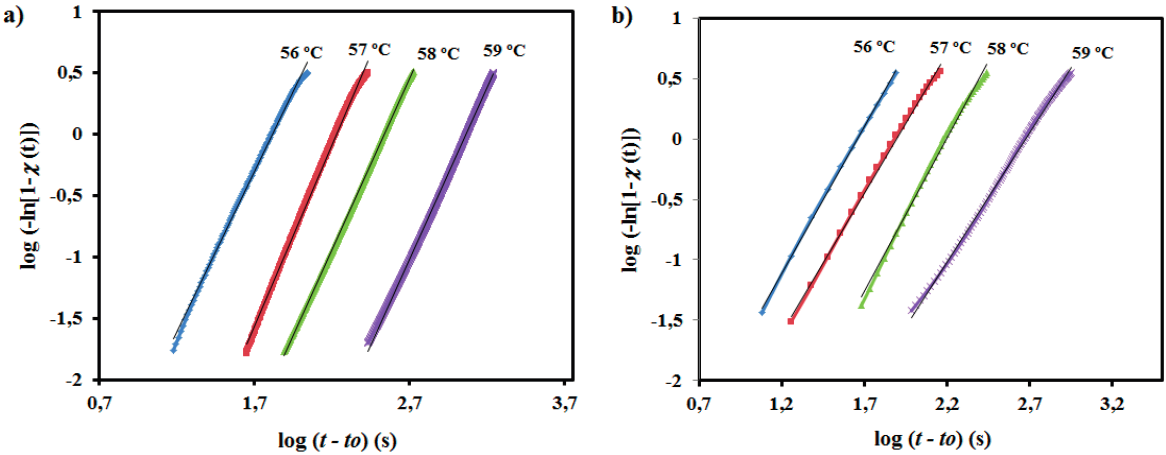
Figure 10. ( a ) Exothermic DSC peaks of isothermal crystallizations of PE99 ( garnet ) and PE99-N 3 ( blue ) samples at temperatures between 56 and 59 °C; ( b ) development of the relative degree of crystallinity of PE99 ( garnet ) and PE99-N 3 ( blue ) samples at different crystallization temperatures.